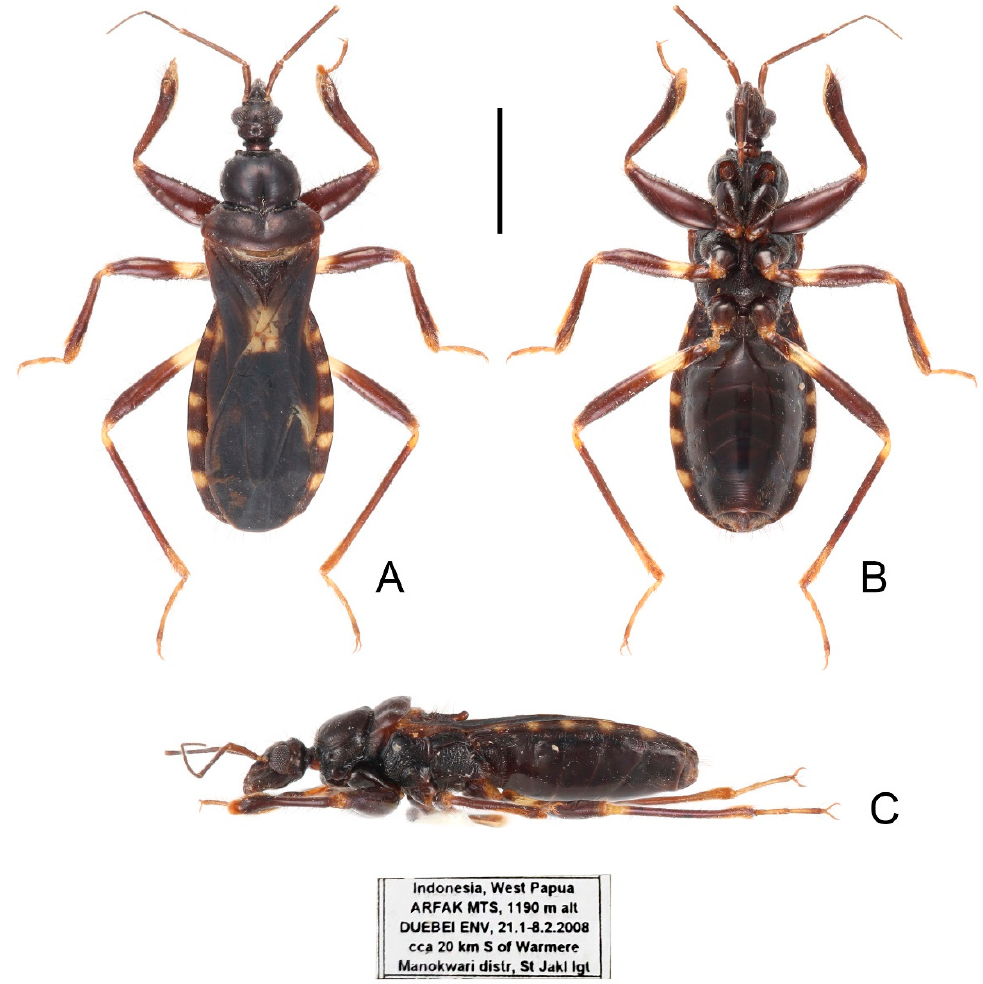
Figure 15. Sigicoris sexguttatus comb. nov. , female, habitus. ( A ) Dorsal view. ( B ) Ventral view. ( C ) Lateral view. Scale bar = 3.00 mm.